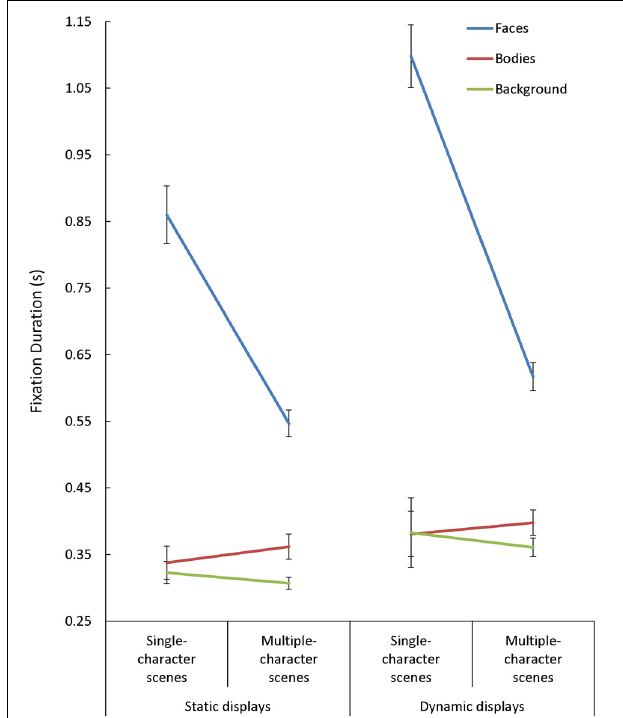
FIGURE 4 | The mean fixation duration(s) for each area of interest (AOI; faces, bodies, backgrounds) while participants viewed static and dynamic displays in single- and multiple-character scenes.